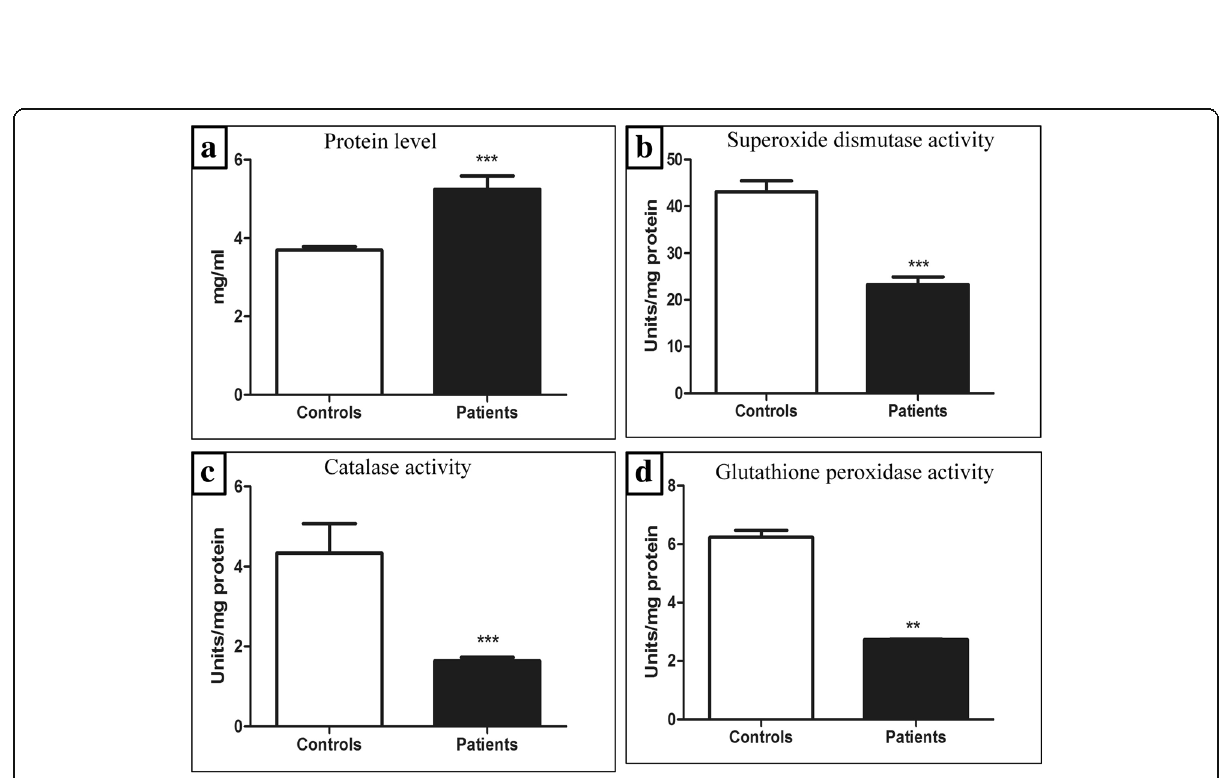
Fig. 4 Statistical analysis of ( a ) protein levels ( b ) activity of superoxide dismutase ( c ) activity of catalase ( d ) activity of glutathione peroxidase in plasma sample of controls and patients. All values are calculated as Mean ± SD. ** p < 0.01; *** p <